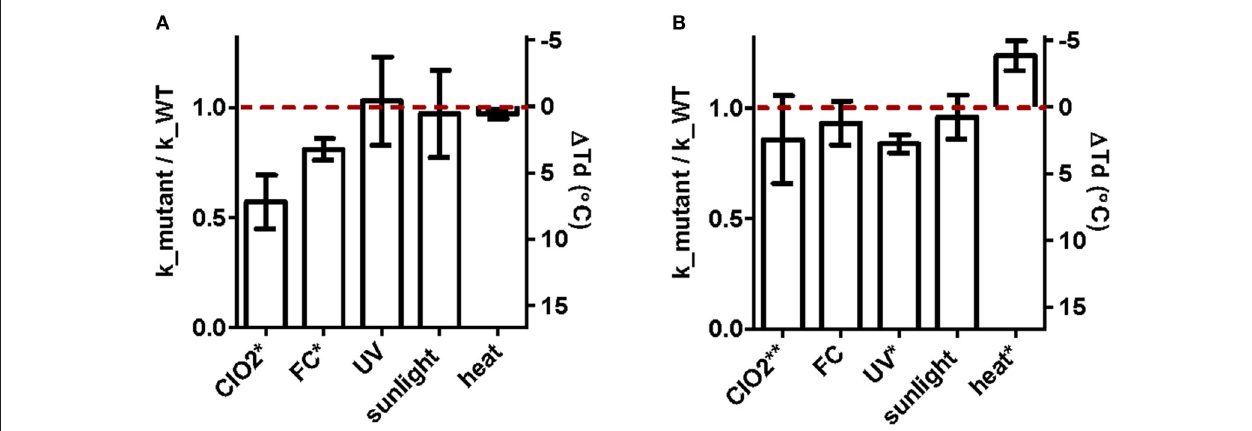
FIGURE 3 | Extent of (cross-) resistance of ClO 2 -resistant populations E_ClO 2 (A) and UV 254 -resistant E_UV (B) upon inactivation by ClO 2 , FC, UV 254 , sunlight, and heat. Except heat, results are presented as the ratio of the inactivation rate constants of the resistant populations to those of the corresponding wild-types (left y-axis). Cross-resistance to heat was determined from the differences in the decay temperature ( 1 Td) between the resistant populations and their wild-type (right y-axis). The red dashed line indicates unity. Bars extending above the red line correspond to reduced resistance, and bars below indicate enhanced resistance compared to the wild-type. Asterisks indicates significant difference in resistance compared to the wild-type at the 95% (*) or 90% (**) confidence level. Error bars represent the propagated standard errors from the model fits to pooled duplicate or triplicate